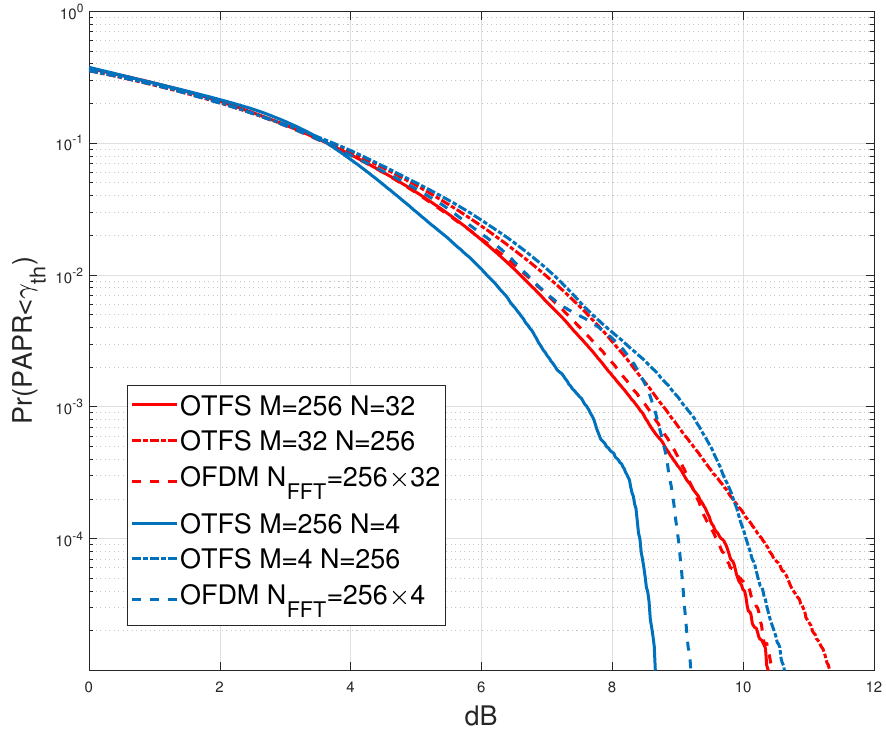
Figure 8. CCDF comparison of OTFS waveform and OFDM waveform at Carrier frequency 2.4